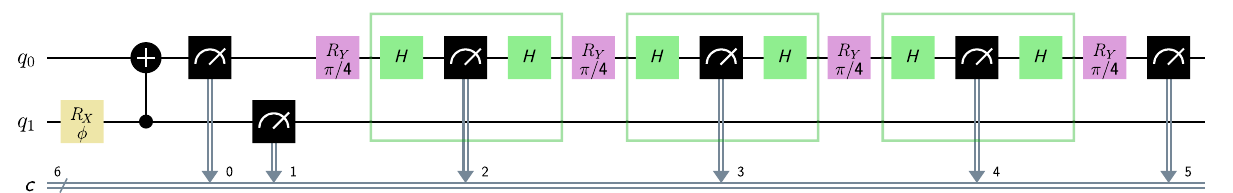
FIG. 4. Quantum circuit employed for the experimental validation of the Jarzynski equality, Eq. (12), in the presence of N − 1 intermediate projective measurements (the case N = 4 is displayed). The green box operations are projective measurements in the σ x basis. The main qubit q 0 initial state is both read off directly, according to the standard TPM, and indirectly by reading the state of the ancilla, according to the AATPM scheme. The outcome of the intermediate measurements is ignored.